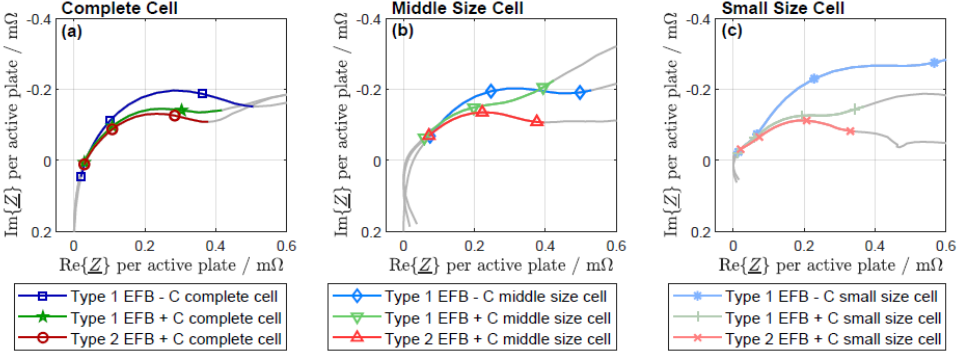
Figure 3. First semicircle of the negative half-cell obtained from EIS at 80% SoC of the laboratory test cells visualized in a Nyquist diagram for ( a ) complete cell: 8P8N/8P9N, ( b ) middle size cell: 3P2N and ( c ) small size cell: 2P1N.